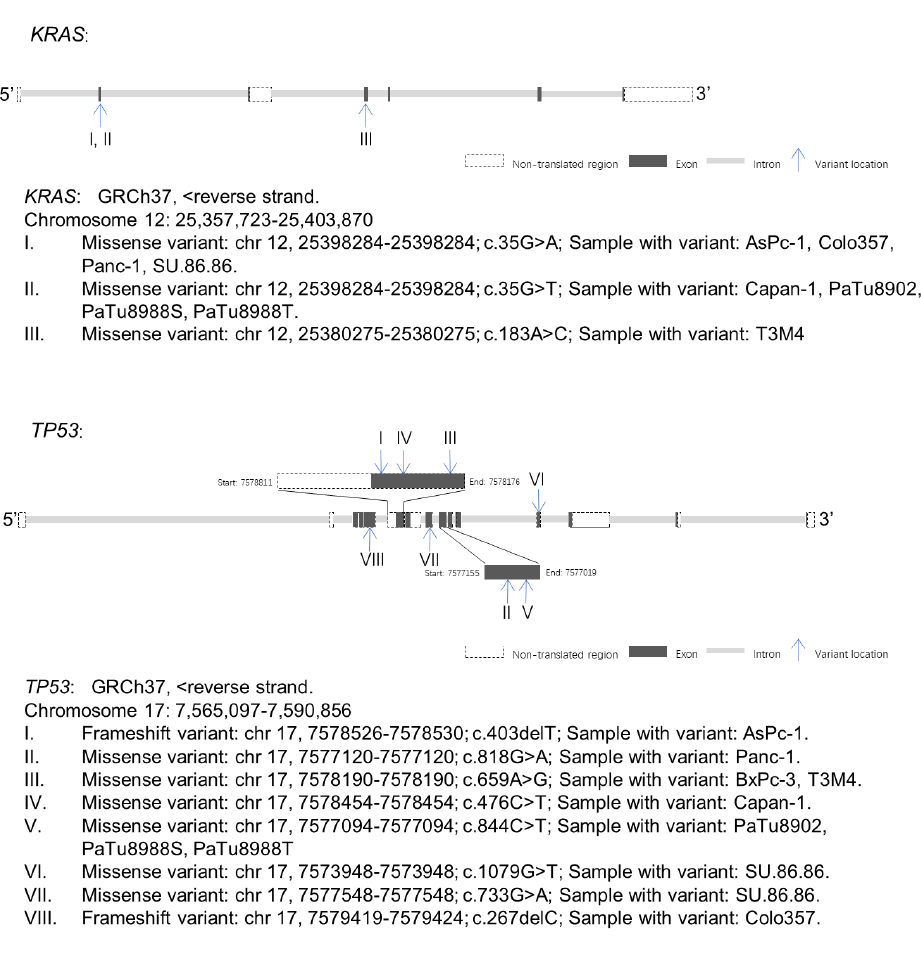
Figure 4. Gene maps indicating the variant sites of KRAS and TP53 in different PDAC cell lines. GRCh37: Genome Reference Consortium Human Build 37, Chr: chromosome. The expressions of KRAS in all PDAC cell lines were higher than those compared to non-neoplastic pancreas tissue (4.16–7.09 vs. 2.14) (Figure 5 and Supplementary Table S12). Both the lowest and highest KRAS expressions were observed in the KRAS c.35G>A variant, which were identified in Colo357 (4.61) and SU.86.86 (7.09), respectively. The